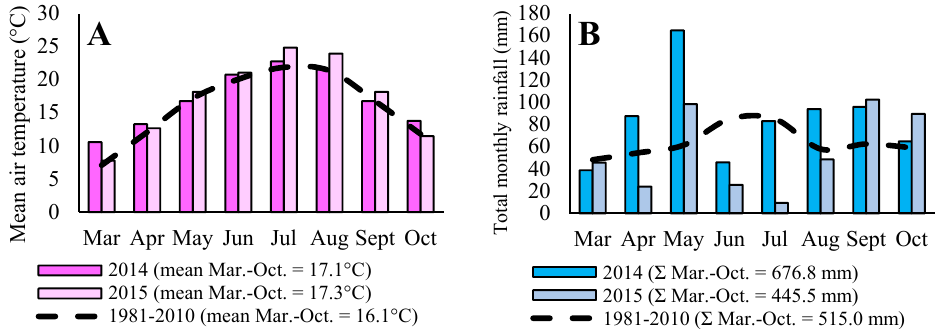
Figure 2. ( A ) Mean air temperature (°C) and ( B ) monthly rainfall (mm) during sugar beet vegetation (March to October) in 2014 and 2015 in comparison to the long-term mean (1981–2010) of climatological station Gradište [38].